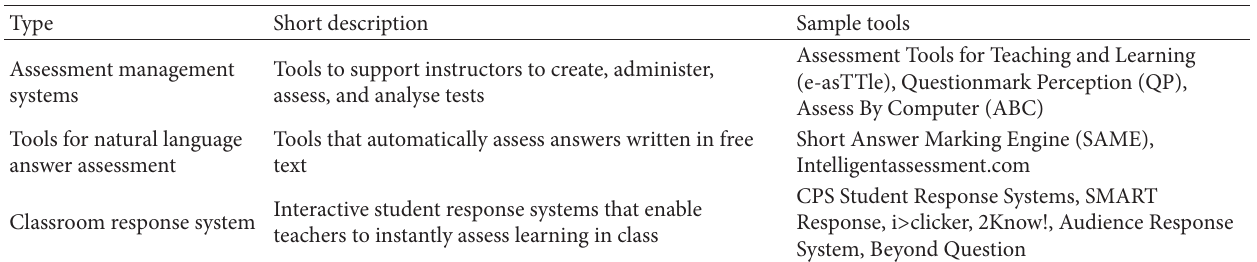
Table 1: Tools for